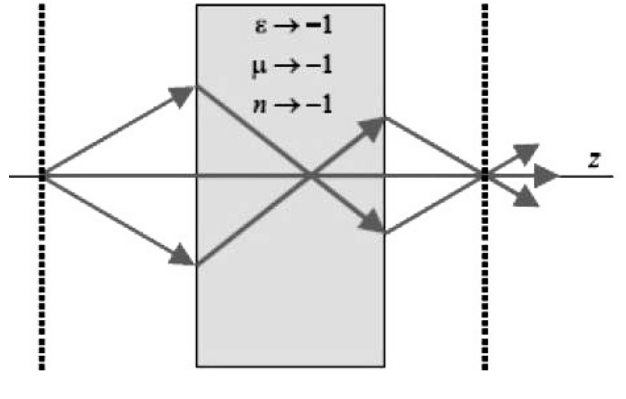
Figure 7: LHM slab as focusing lens [8]